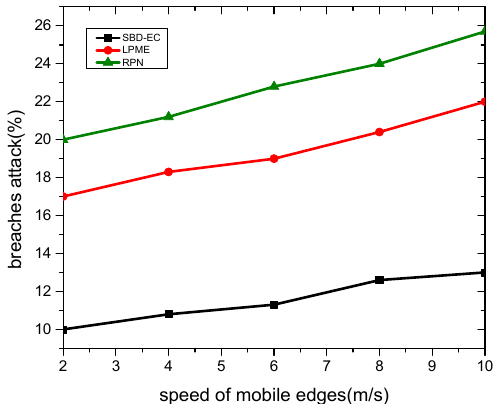
Figure 11. Breaches attack and mobility.